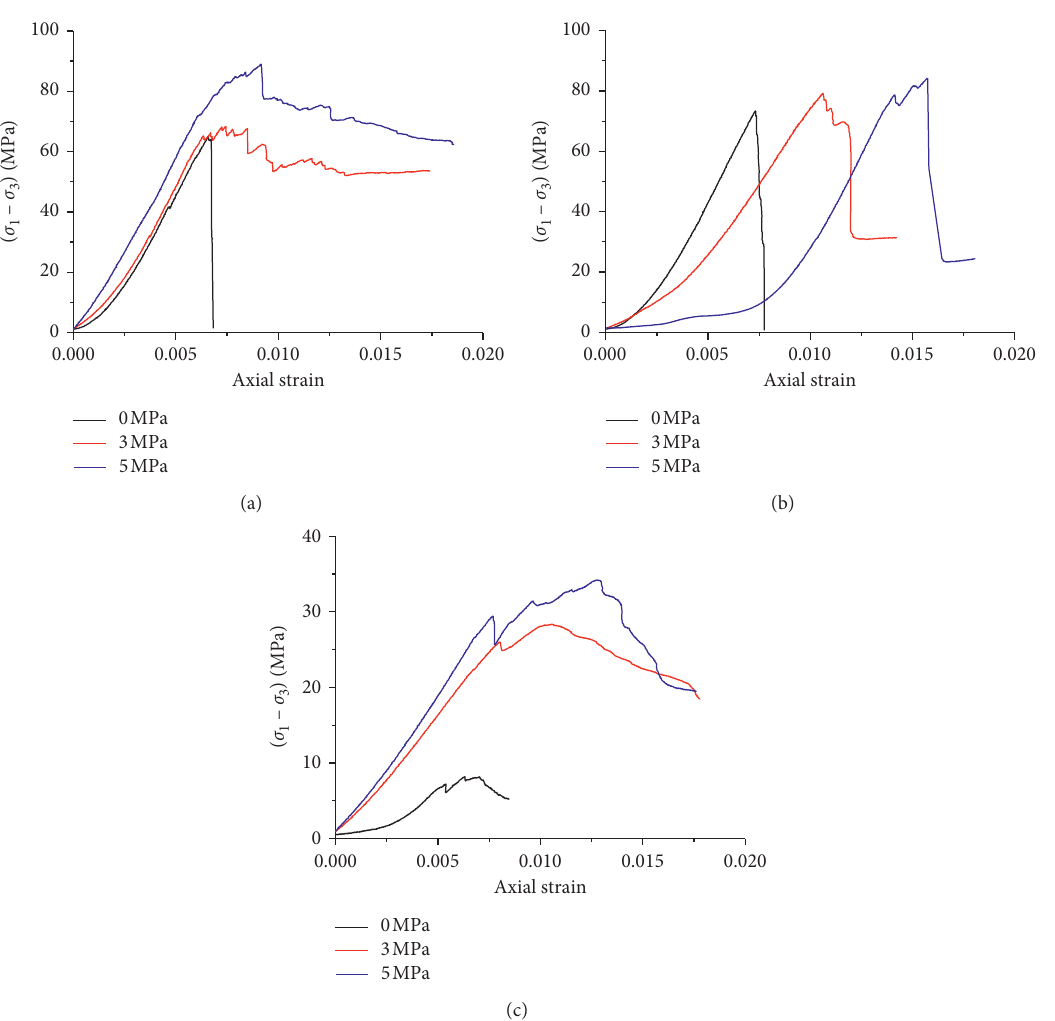
Figure 3: Stress-strain curves of the roof, the floor, and the coal specimens under different confining pressures. (a) Roof specimen. (b) Floor specimen. (c) Coal specimen.